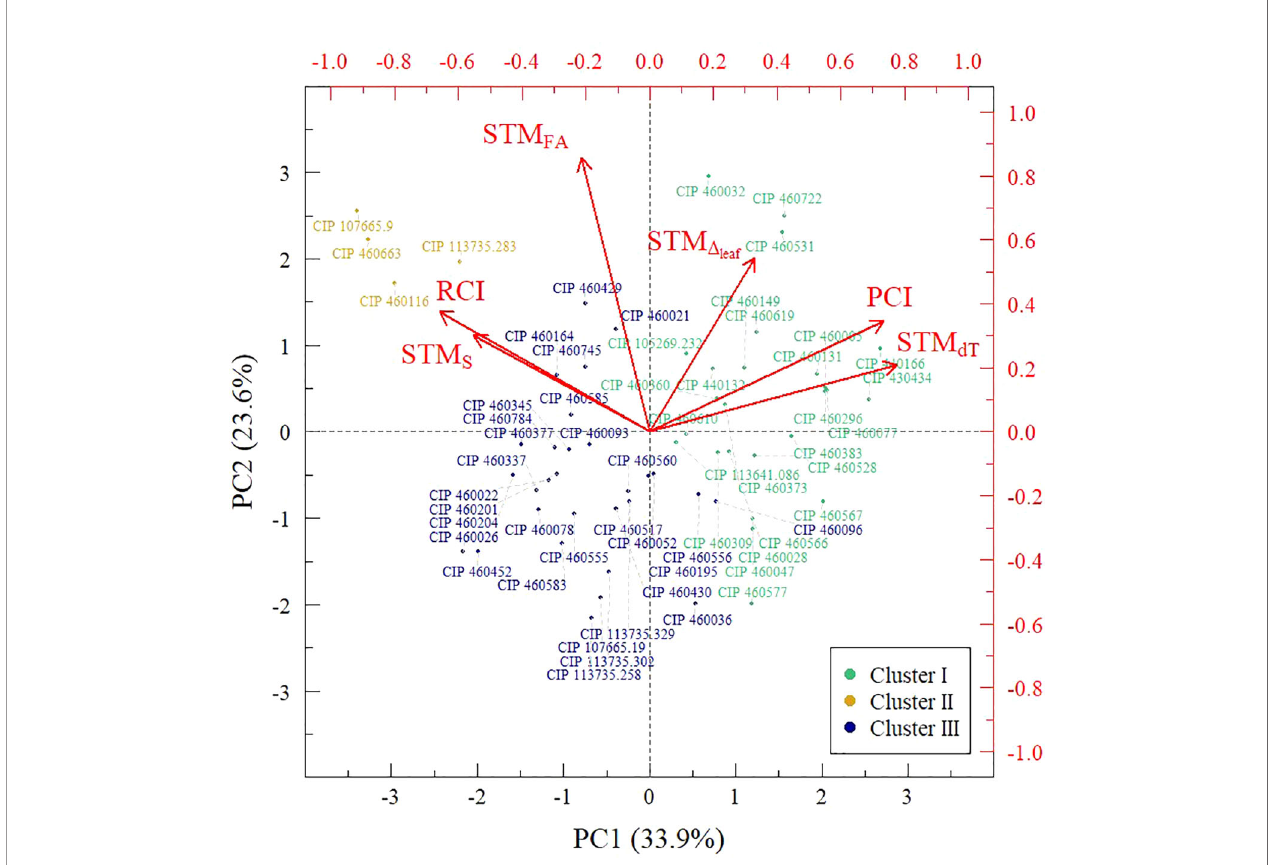
FIGURE 4 | Clustering analysis and 2D ordination of sweetpotato cultivars and its CWR species based on Principal Component Analysis for component loadings (STM traits, PCI and RCI). Clusters I, II and III correspond to Fernandez's (1992) Groups B, C, and D, respectively.